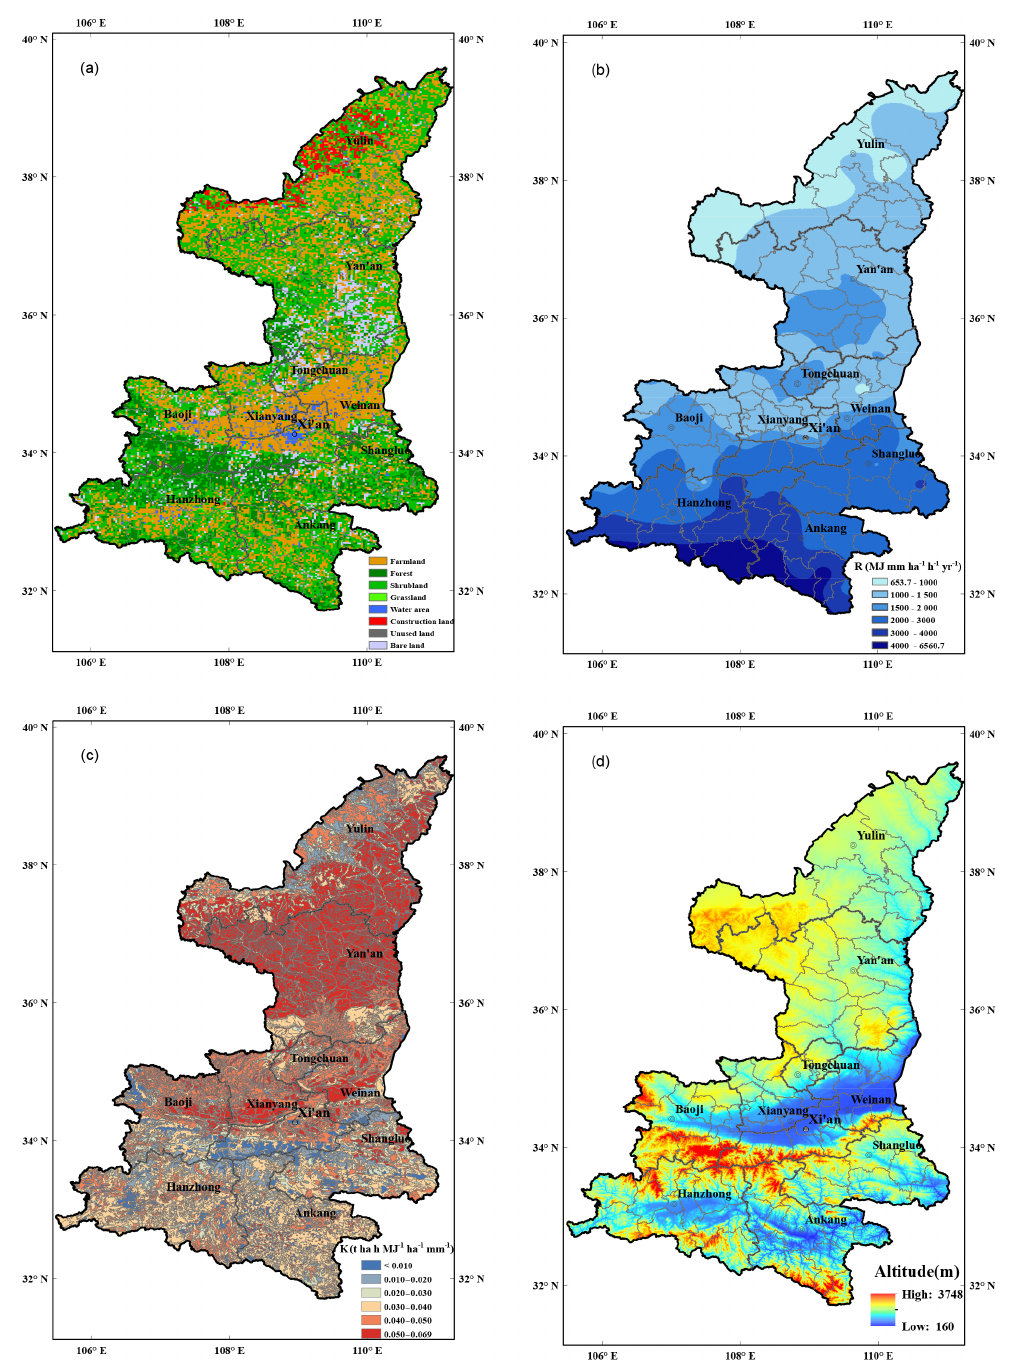
Figure 5. Spatial distributions of land use (a) , rainfall erosivity (b) , soil erodibility (c) and topography (d) for Shaanxi Province.